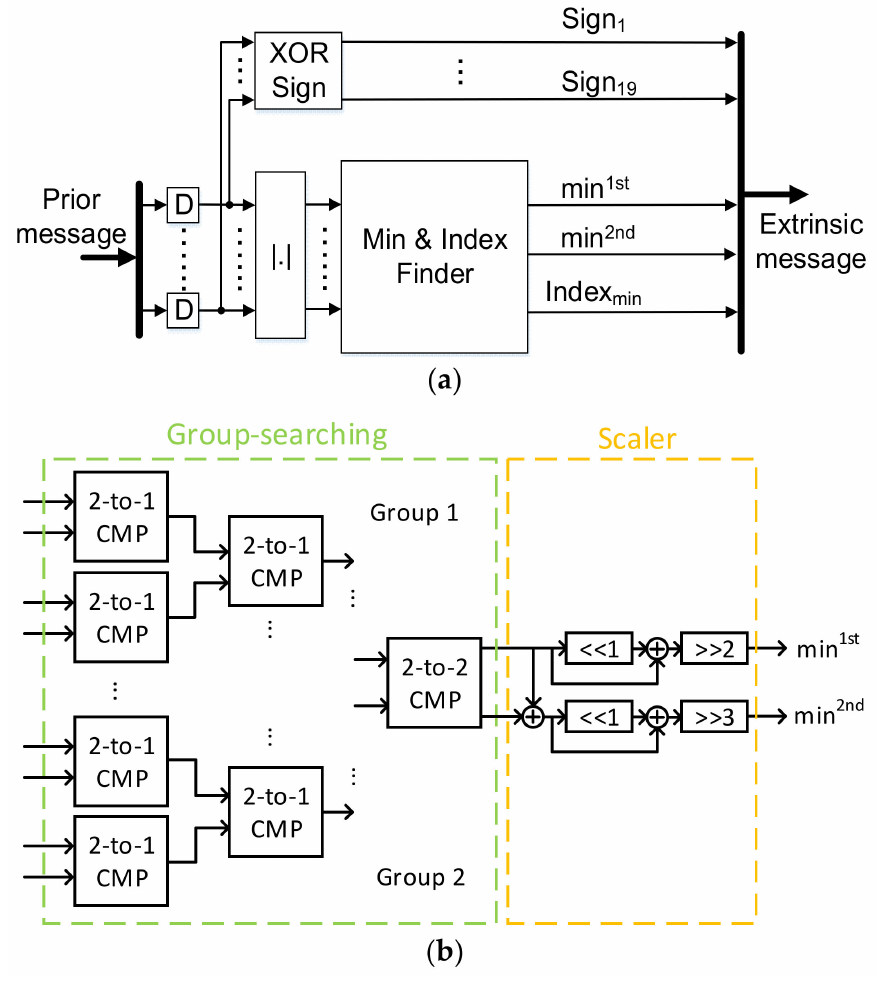
Figure 8. Architecture of ( a ) CNU and ( b ) Min & Index Finder using the proposed compensation scheme of group